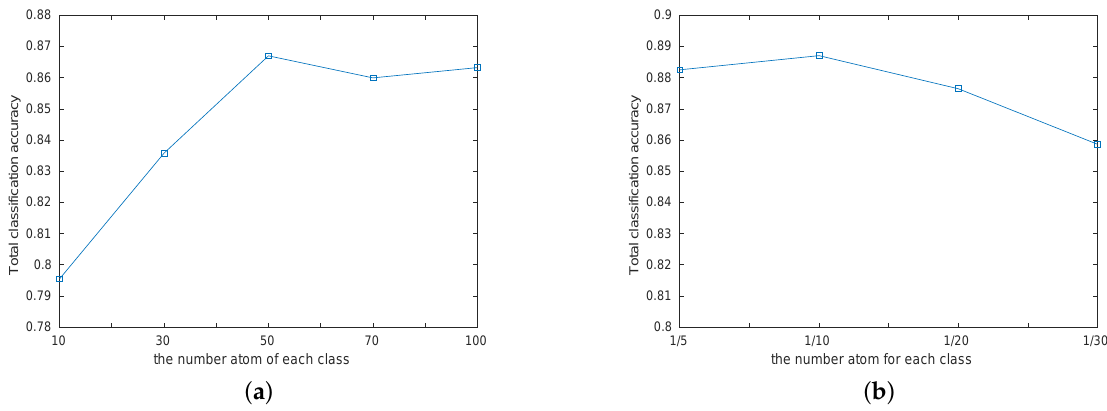
Figure 12. Eigenvalue versus varying scale parameter atom number. ( a ) with the same atom number for each class. ( b ) with atom number in proportion for each